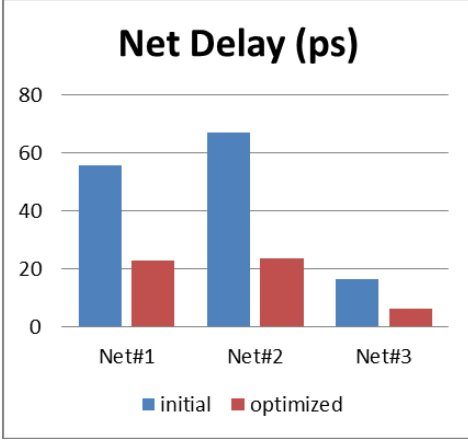
Figure 7. Wire delay reduction.